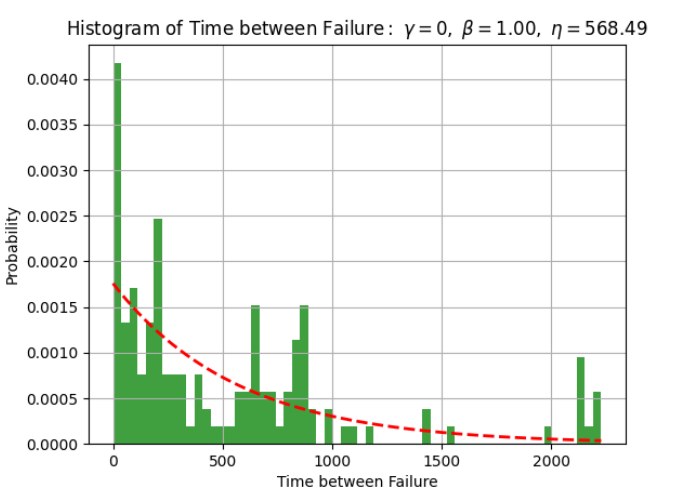
Figure 2. Histogram of time between failures and Weibull distribution with shape parameter of 1.0 and characteristic life of 568.49